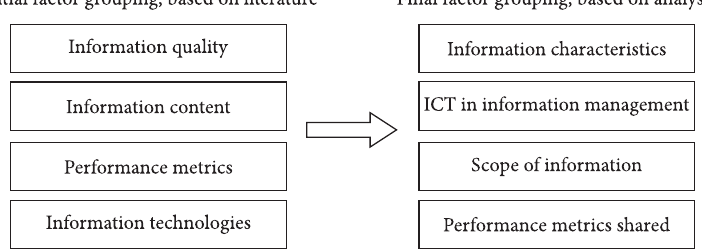
Table 2. Factors related to information management in supply chains. An Exploratory Factor Analysis results (n = 200) (source: own elaboration) Factor Indicators Factor loadings